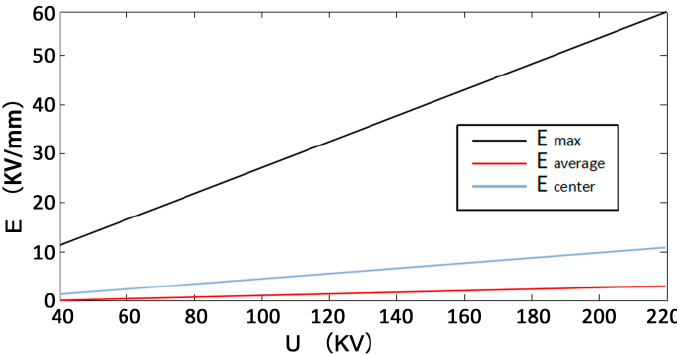
Figure 13. Variation of rock electric field with voltage.